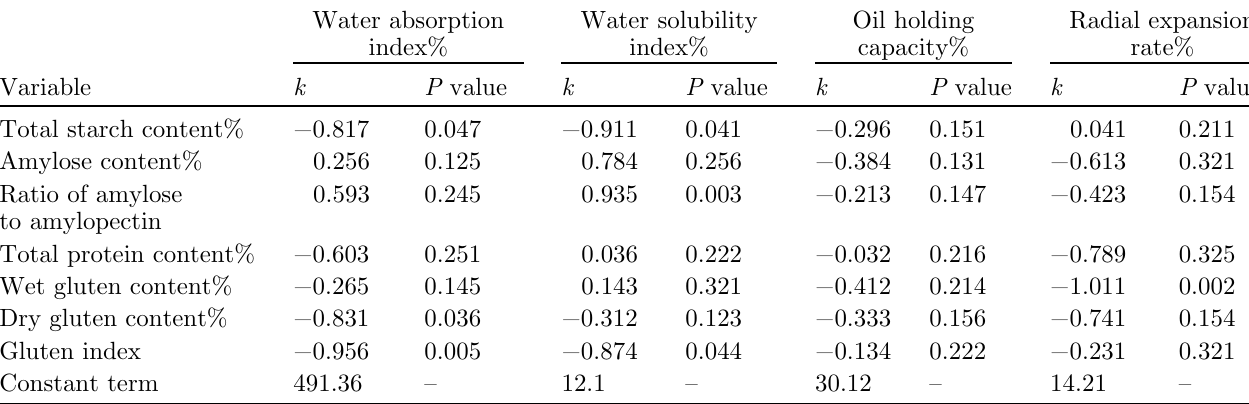
Table 2. Regression analysis of factors in fl uencing the quality index of fl our